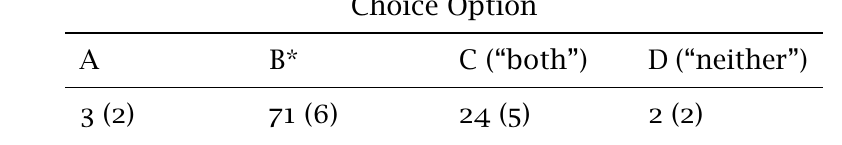
Percentages of choices of each option (standard errors in parentheses), Experiment 1 . “Strengthened" alternative indicated by